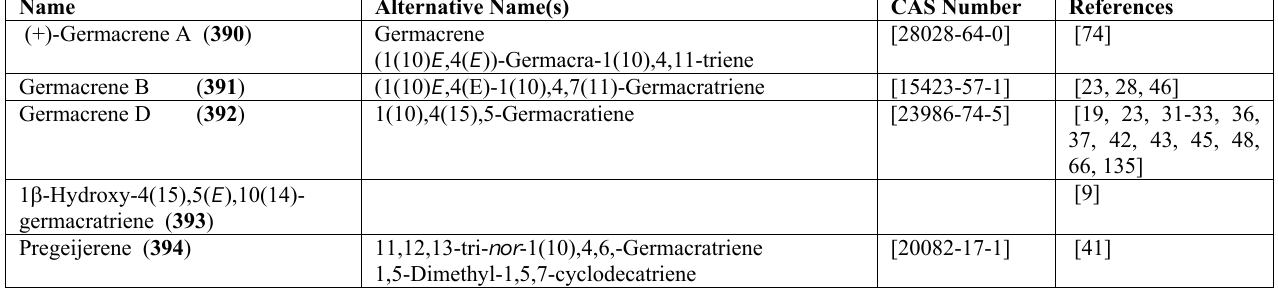
Table 31. Germacrane Sesquiterpenoids (1,7-Dimethyl-4-(1-methylethyl)cyclodecane,